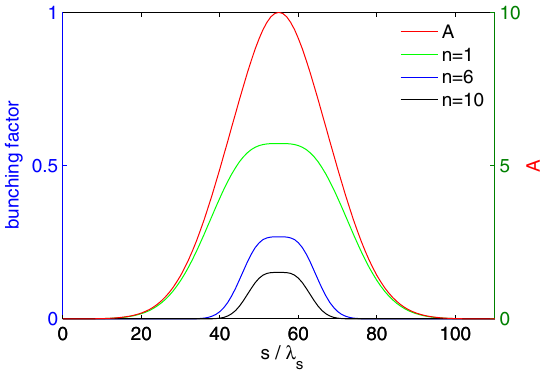
FIG. 6. Normalized TBPs of the electron bunching as a func- tion of the modulator period number for different harmonics of the seed ( n ¼ 1 , 6, and